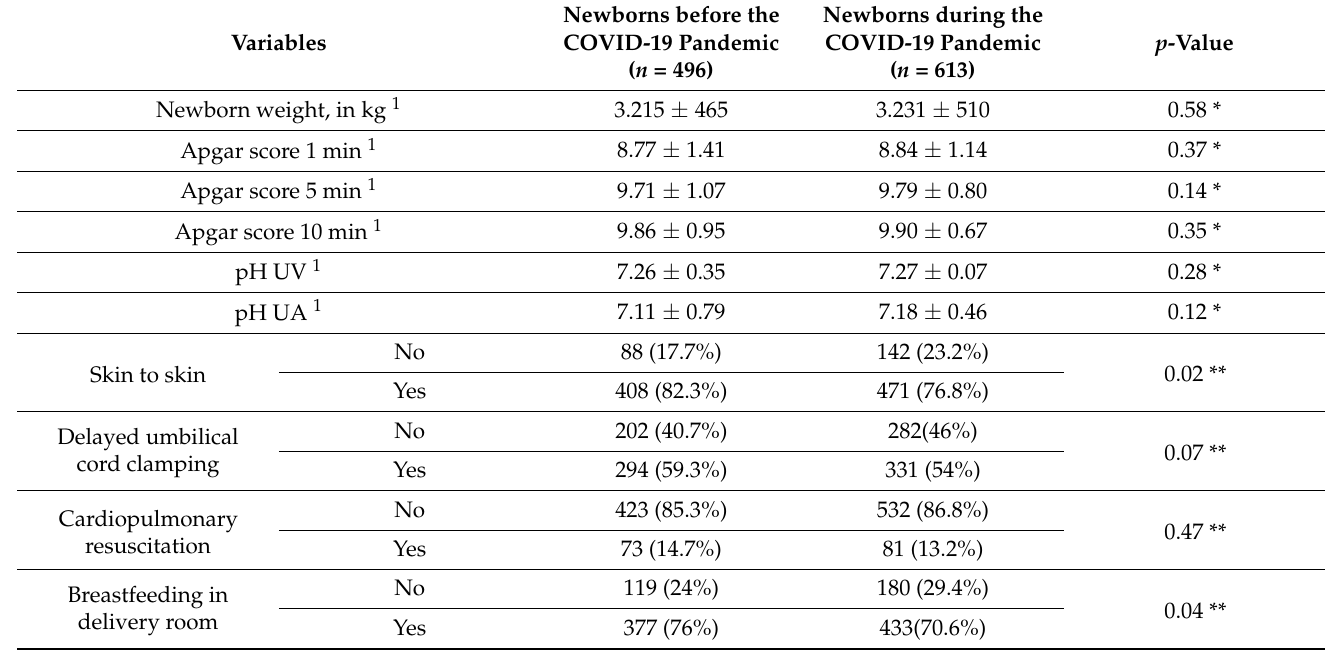
Table 4. Comparison of perinatal data between the two groups, “before the COVID-19 pandemic” and “during the COVID-19